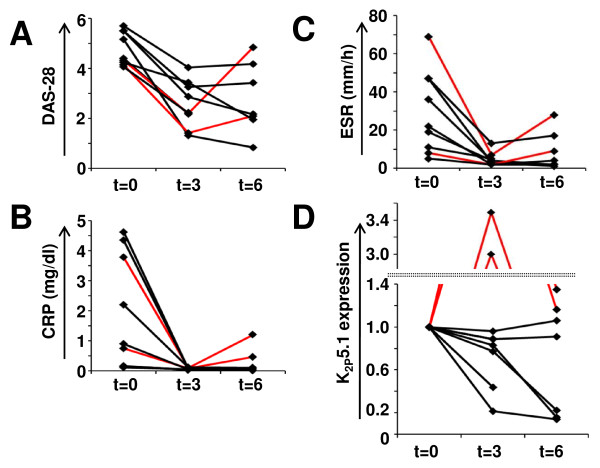
A longitudinal study of RA patients receiving tocilizumab. A) DAS28 B) CRP values, C) ESR values and D) relative K2P5.1 expression levels are compared for patients with therapy switch to tocilizumab over six months. Note that the y-axis in D) is split for better clarity and that two patients are marked in red.